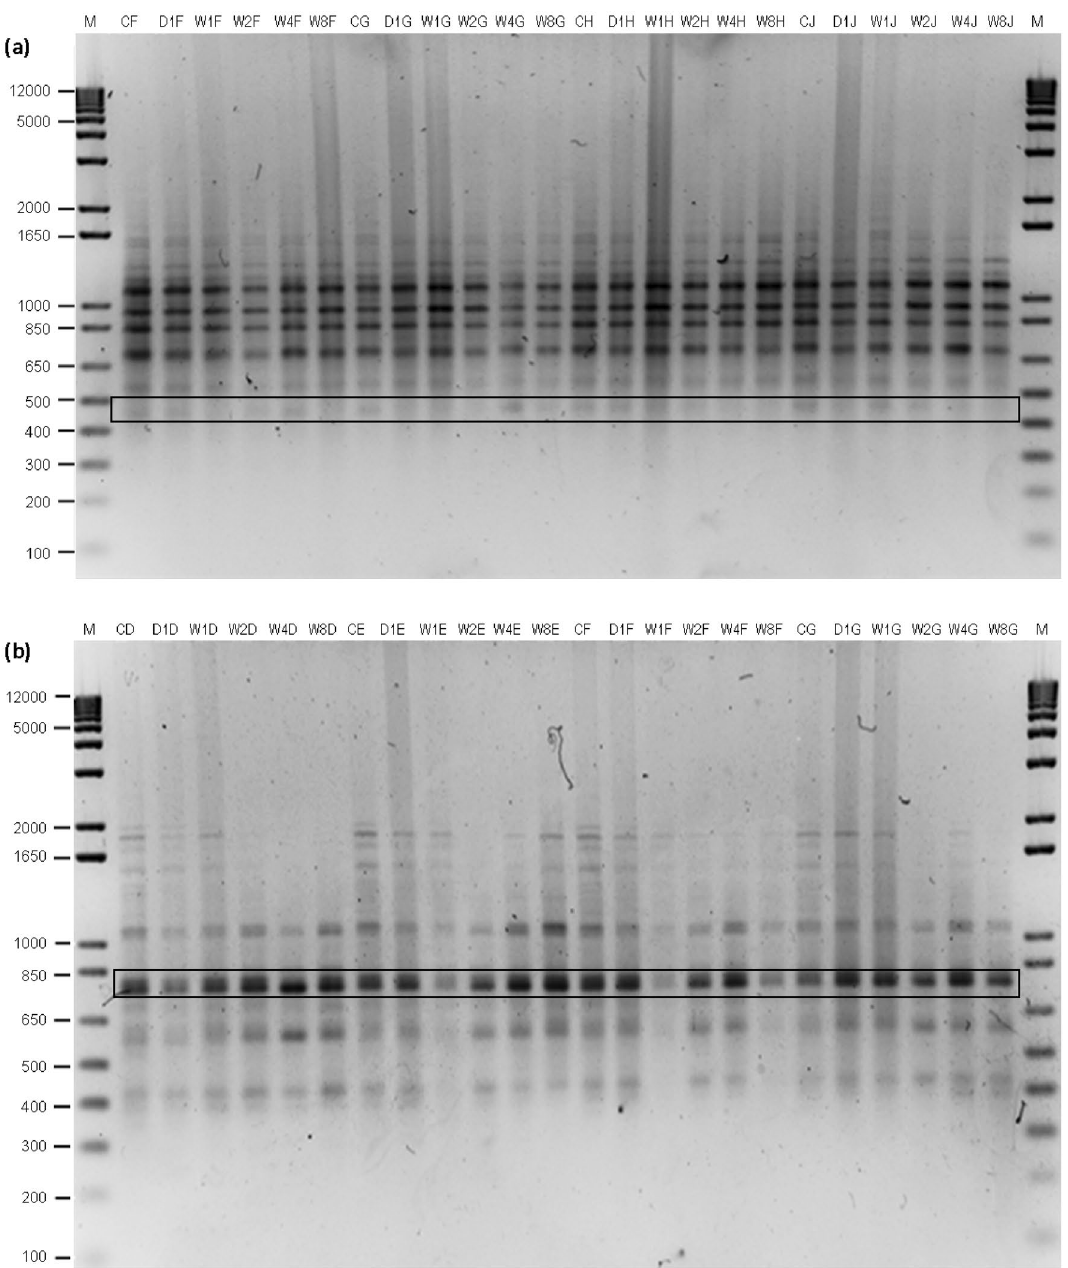
Figure 4. ( a ) Gel image obtained using ISSR primer UBC 840, where the highlighted portion of the image shows the presence of polymorphic bands, and ( b ) gel image obtained using ISSR primer UBC 841, where the highlighted portion of the image shows the presence of monomorphic bands. C control plantlet, A-J Plantlets A-J, D1 Day 1, W1-8 Week 1–8. The original gel is presented in Supplementary Fig. S4,